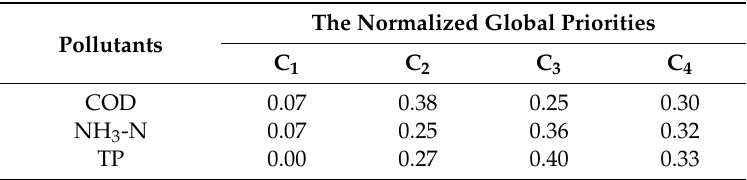
Table 8. The global priorities across the alternatives at the decision-making level, with respect to the overall